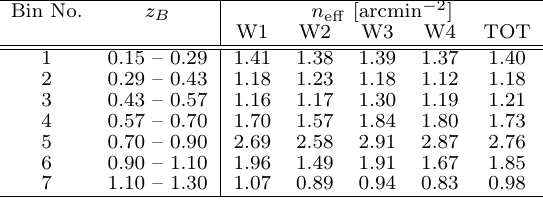
Table 1 Redshift bins used in this analysis along with the effective density n eff per bin and field. The last column shows the total n eff per